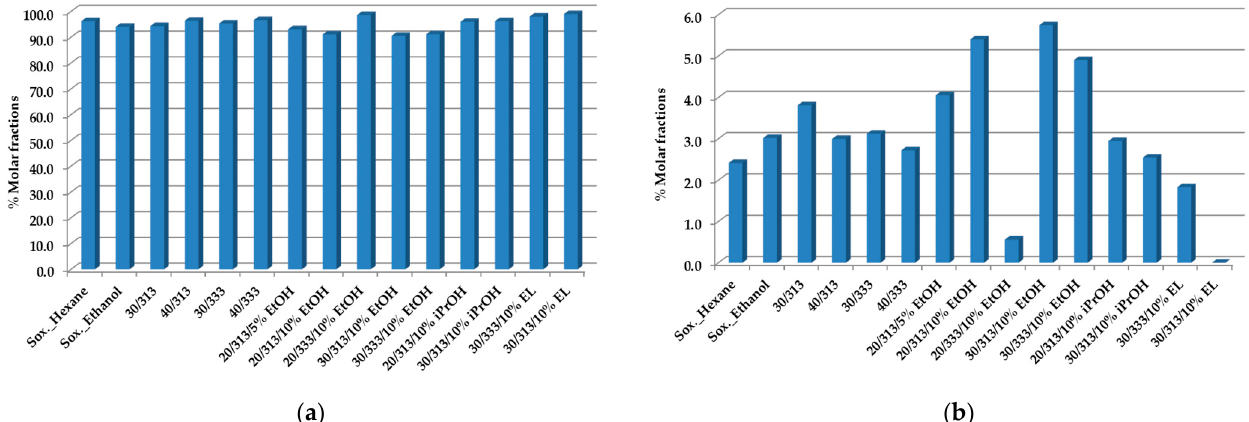
Figure 1. TAGs ( a ) and 1,2 DAGs ( b ) composition of spent coffee oils obtained by Soxhlet with hexane, ethanol, and scCO 2 extraction at a flow rate of F = 1.8 × 10 − 3 kg · min − 1 , as established by 1 H-NMR quantitative analysis [50]. All values represent % molar fractions.